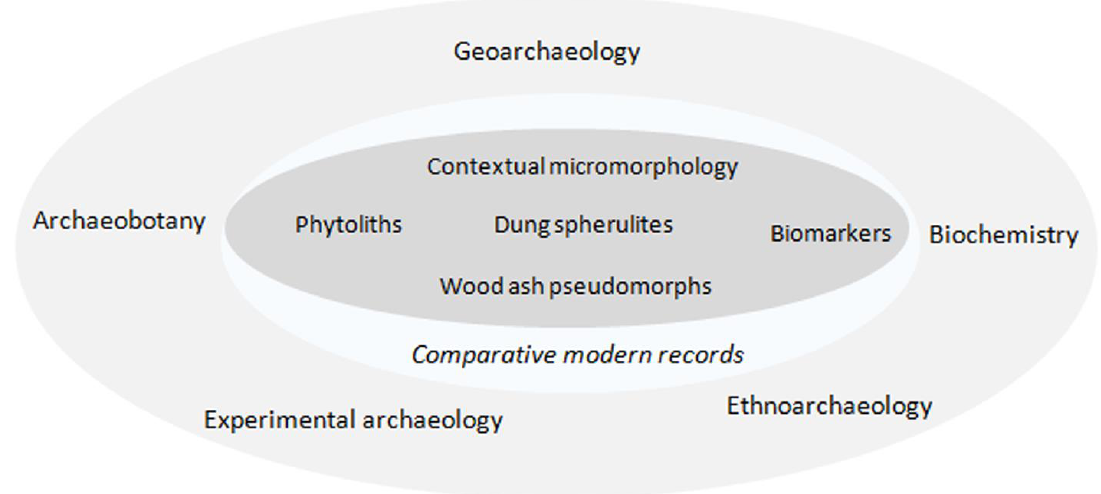
Figure 1. Schematic diagram showing a model for the identification and characterisation of archaeological livestock dung based on comparative modern reference records and ethnoarchaeological studies conducted in the research areas.